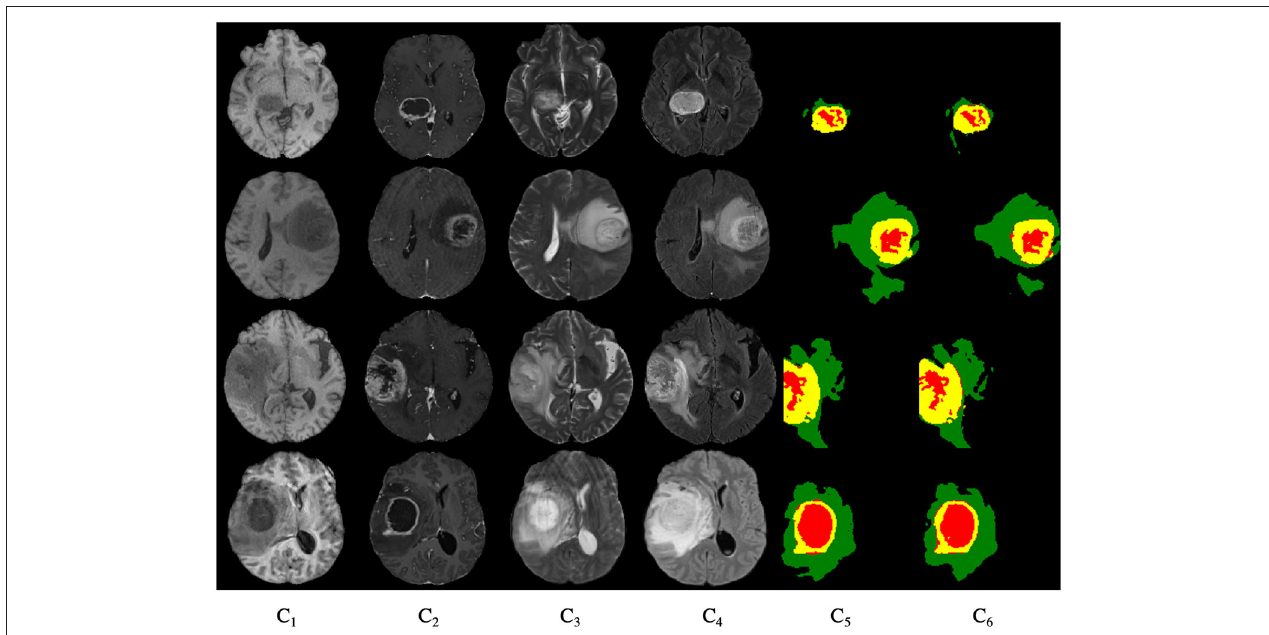
FIGURE 9 | Segmentation results for four cases. C 1 are the images represent one axial MRI slice obtained in T1-weighted, C 2 are the T1c-weighted, C 3 are the T2-weighted, C 4 are the FLAIR-weighted, C 5 are the the standard tumor segmentation results manually labeled by experts, and the C 6 show the segmentation results obtained in this